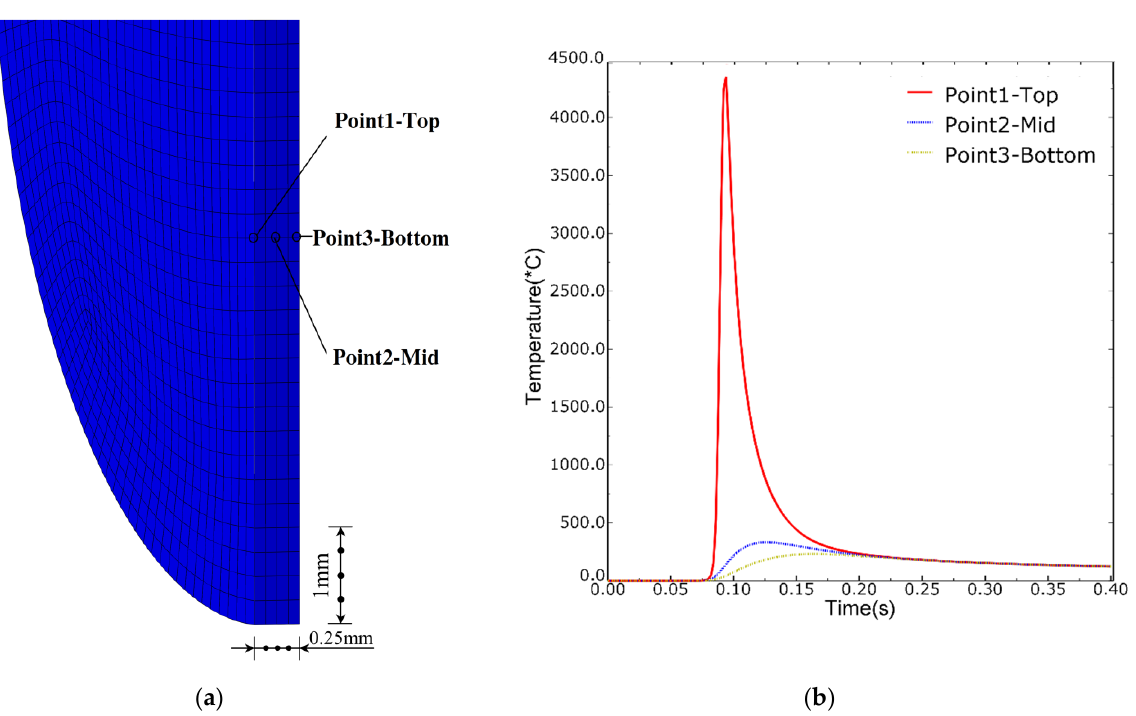
Figure 7. Simulation of the temperature field of brittle sapphire material based on ABAQUS. ( a ) Finite element mesh division. ( b ) Temperature curve varies with time.